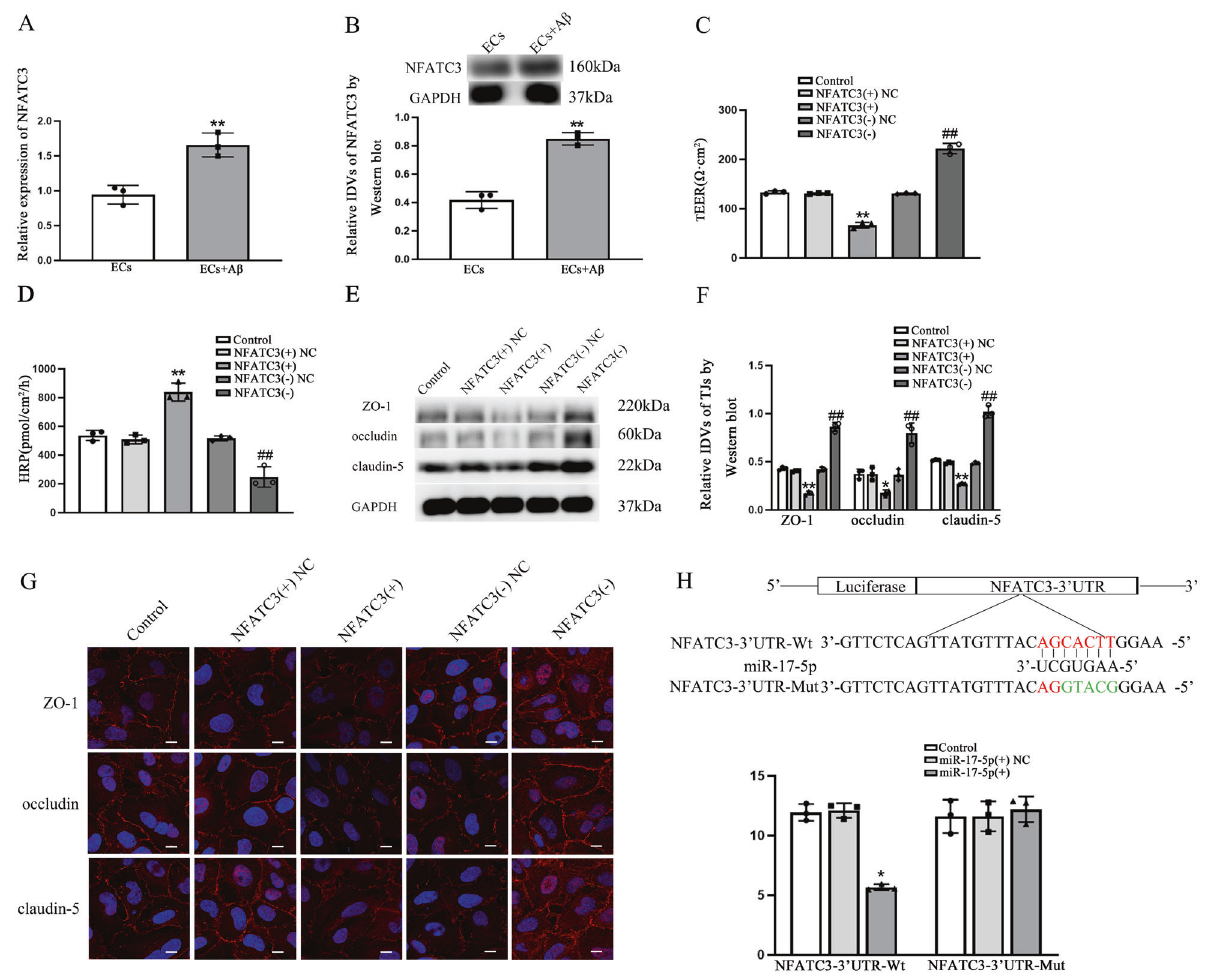
Fig. 6 NFATC3 was up-regulated in A β (1 – 42)-incubated ECs to facilitated the increase of BBB permeability, and NFATC3 was direct target of miR-17-5p. A , B Relative expression of NFATC3 in ECs and A β (1 – 42)-incubated ECs was detected by qRT-PCR and western blot. ** p < 0.01 vs. ECs group, data were presented as mean ± SD ( n = 3, each). C TEER values of BBB were presented as Ω cm 2 . **p < 0.01 vs. NFATC3( + )NC group. ## p < 0.01 vs. NFATC3( − )NC group, data were presented as mean ± SD ( n = 3, each). D HRP fl ux was calculated as pmol/cm 2 /h. **p < 0.01 vs. NFATC3( + )NC group. # # p < 0.01 vs. NFATC3( − )NC group, data were presented as mean ± SD ( n = 3, each). E , F The relative expression levels of ZO-1, occludin and claudin-5 were measured via western blot. GAPDH was used as an internal control. * p < 0.05 and ** p < 0.01 vs. NFATC3( +